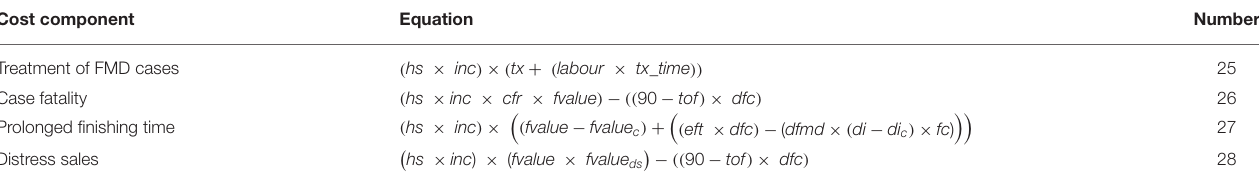
TABLE 4 | Equations used to estimate the impact of foot-and-mouth disease (FMD) among beef feedlot systems. Cost component Equation Treatment of FMD